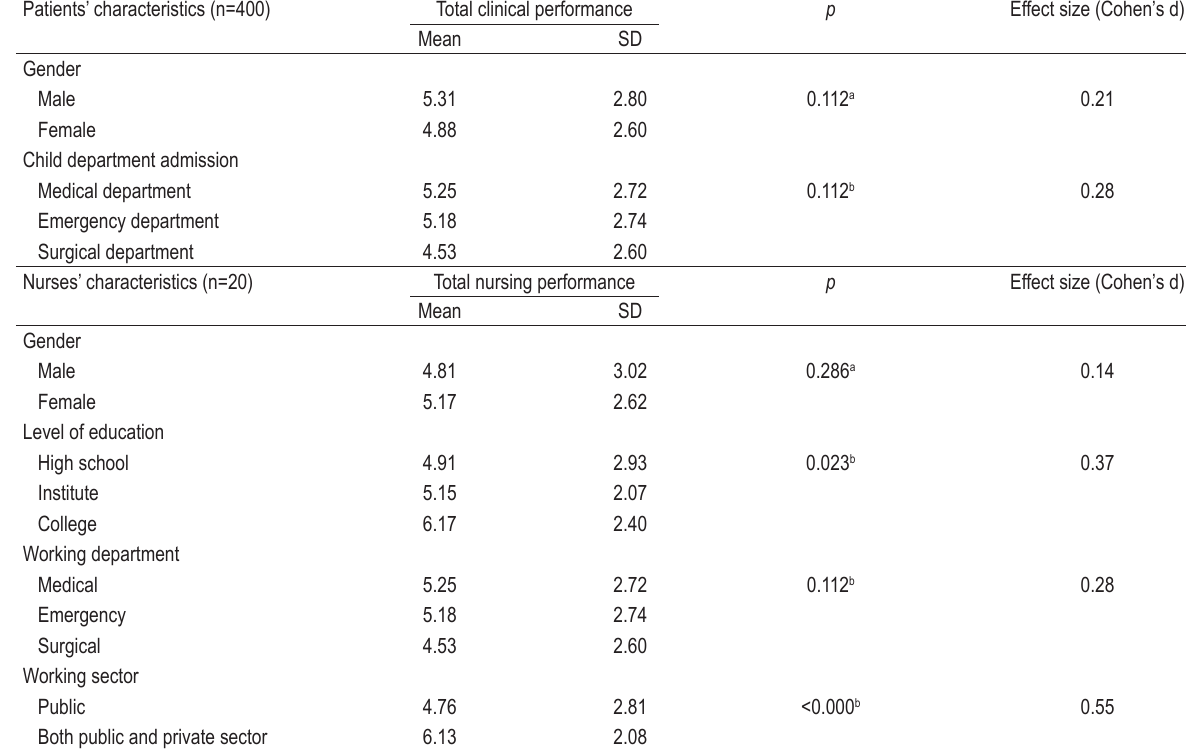
TABLE 3. Comparisons of total clinical performance score of nurses applied to different children during venipuncture procedures Patients’ characteristics (n=400)